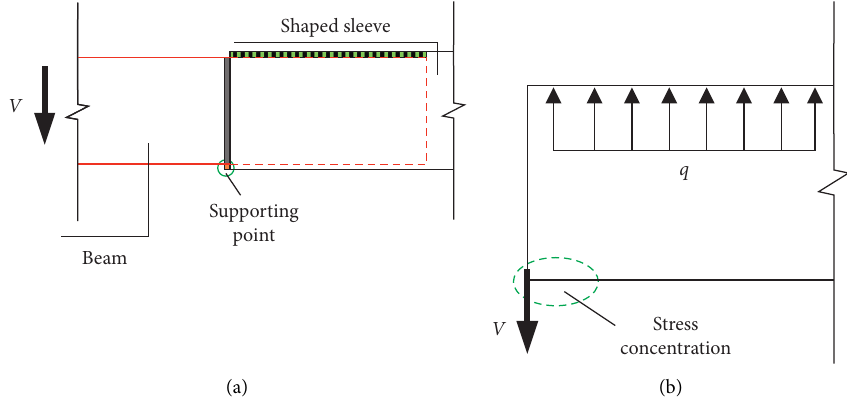
Figure 18: Force state of shaped sleeve. (a) Welding joints distribution and (b) stress concentration.